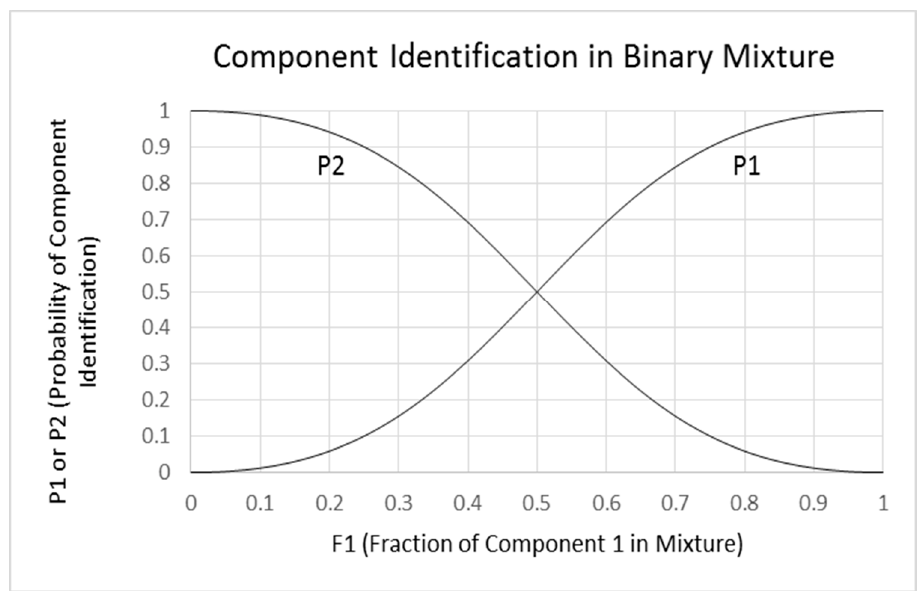
Figure 7. Binary mixture odor identification: Hettinger and Frank model. P1 shows a plot of the probability of identification (P 1 ) of component 1 as a function of the relative intensity (F 1 ) of component 1. P2 shows the corresponding plot for the identification of component 2. The plot is for the equation P 1 = F 12 /(F 12 + (1 − F 1 ) 2 ) and is based on the equation of Olsson and Cain [17] where P 1 = F 12 /(F 12 + F 22 ). The two plots are symmetric and sigmoid, with the points at 0.5 corresponding to matched intensities of the two components. P 1 and P 2 are the probabilities of identification of components 1 and 2, respectively, where P 1 + P 2 = 1. F 1 and F 2 are the fractional intensities of the respective unmixed components, where F 1 + F 2 = 1. The steepness of the functions is determined by the F 1 and F 2 exponents, which in the general model equals 2. The slope (dy/dx) at the inflection point is equal to 2 for the P1 function and − 2 for the P2 function.